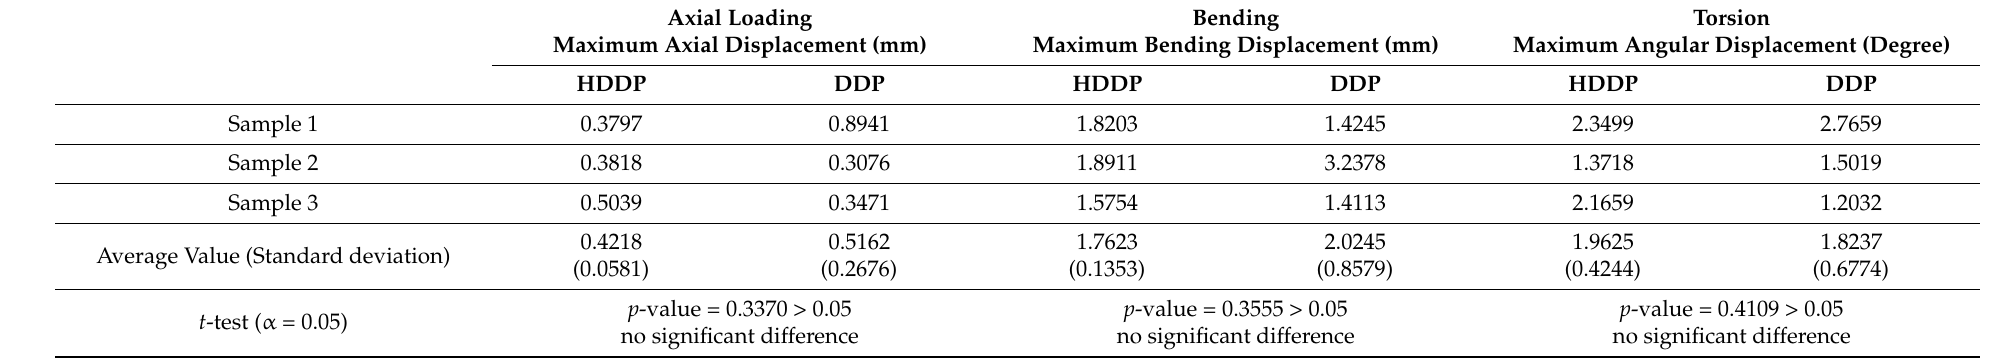
Figure 7. Illustration of the biomechanical fatigue test displacements under ( a ) axial load, ( b ) bending, and ( c ) torsion. Table 2. Biomechanical fatigue test displacement results under axial load, bending, and torsion .